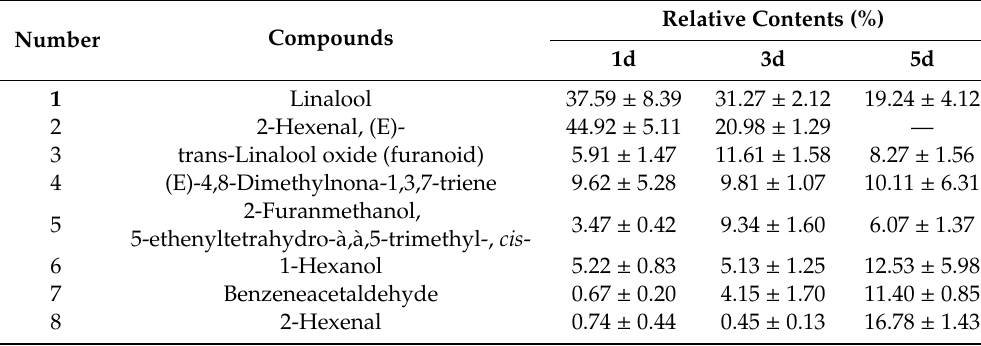
Figure 6. Volatile components were detected in different days of B. acuminata petals. Table 2. Main terpenoids were detected in different days of B. acuminata petals.